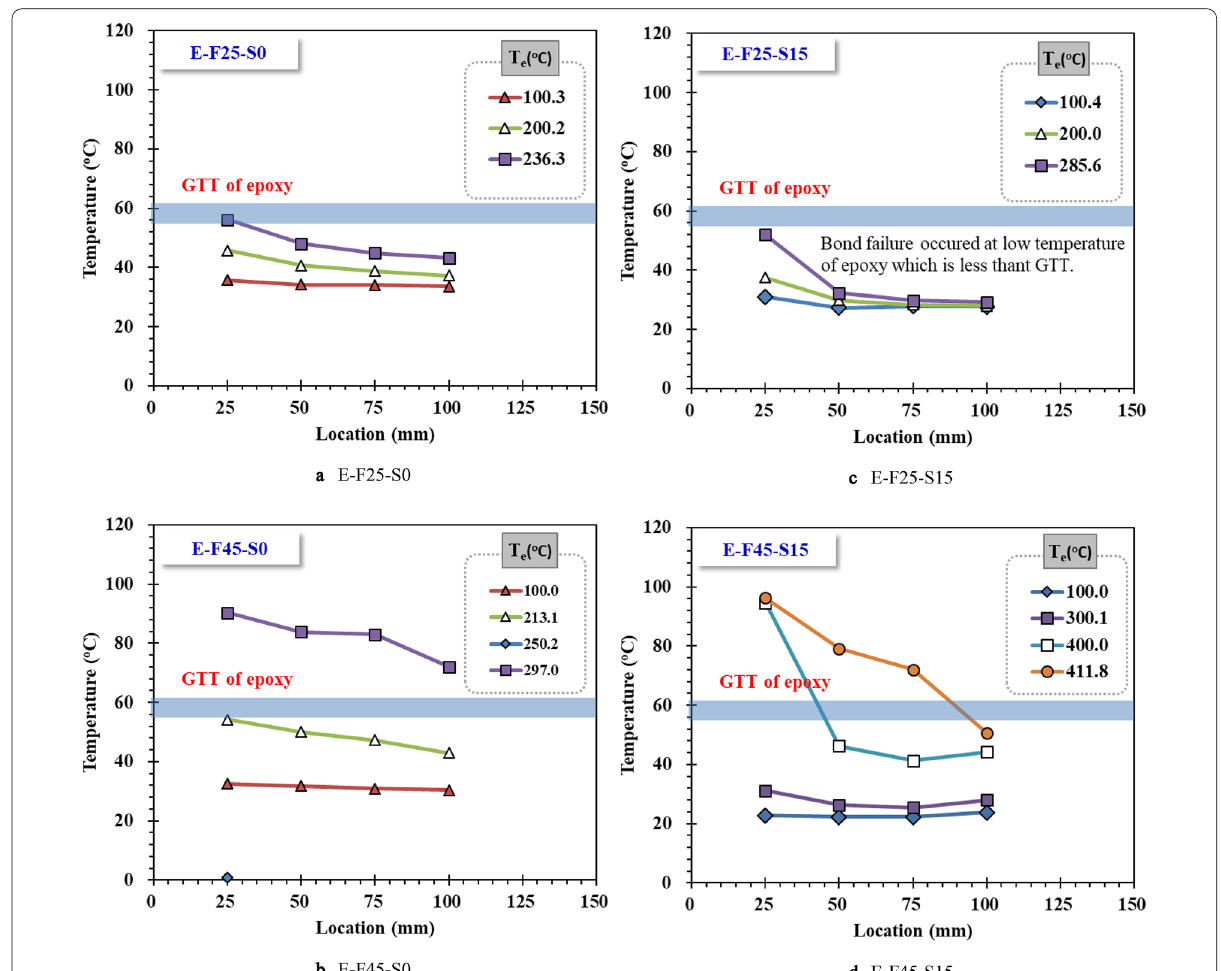
Fig. 15 Temperature profiles of epoxy along its length in EBR